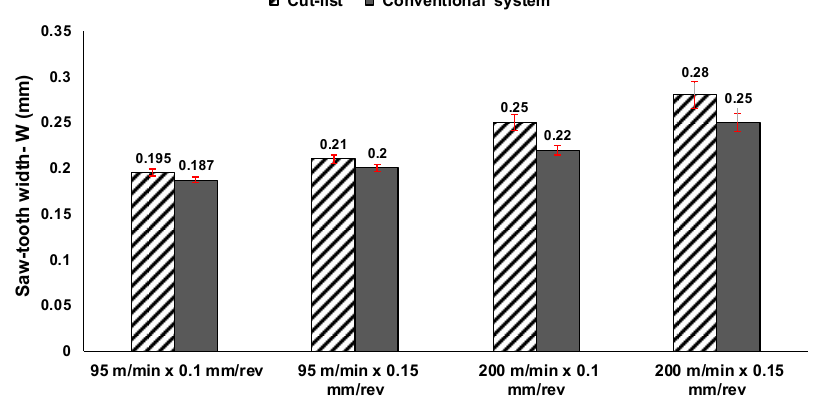
Figure 20. Average saw-tooth width of serrated chips at various cutting conditions.